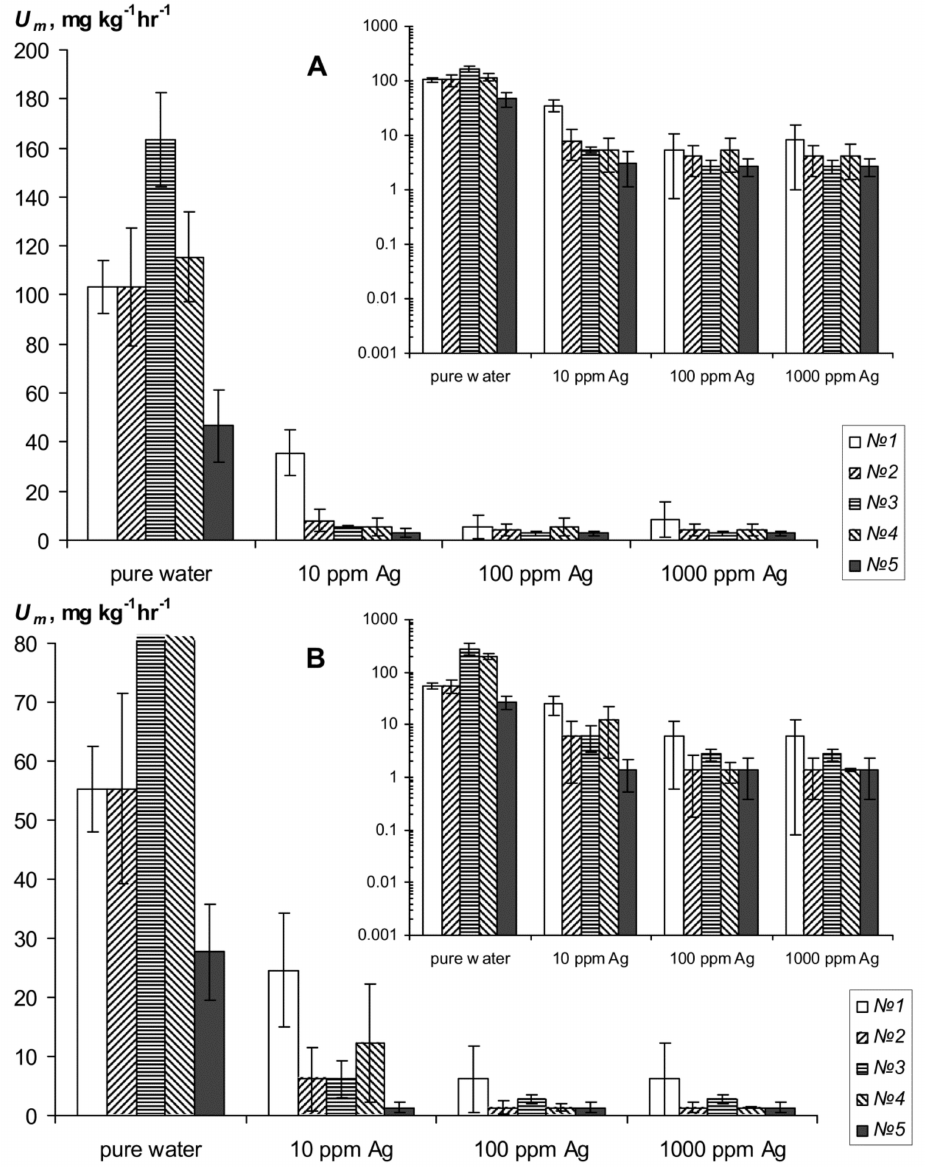
Figure 3. Carbon dioxid emission as an indicator of resistance to biodegradation of the hydrogels and their compositions with silver. N o N o 1–4 are different types of hydrogels (see “Objects and methods”); ( A ) is ionic silver and ( B ) colloidal silver; insets are semi-logarithmic